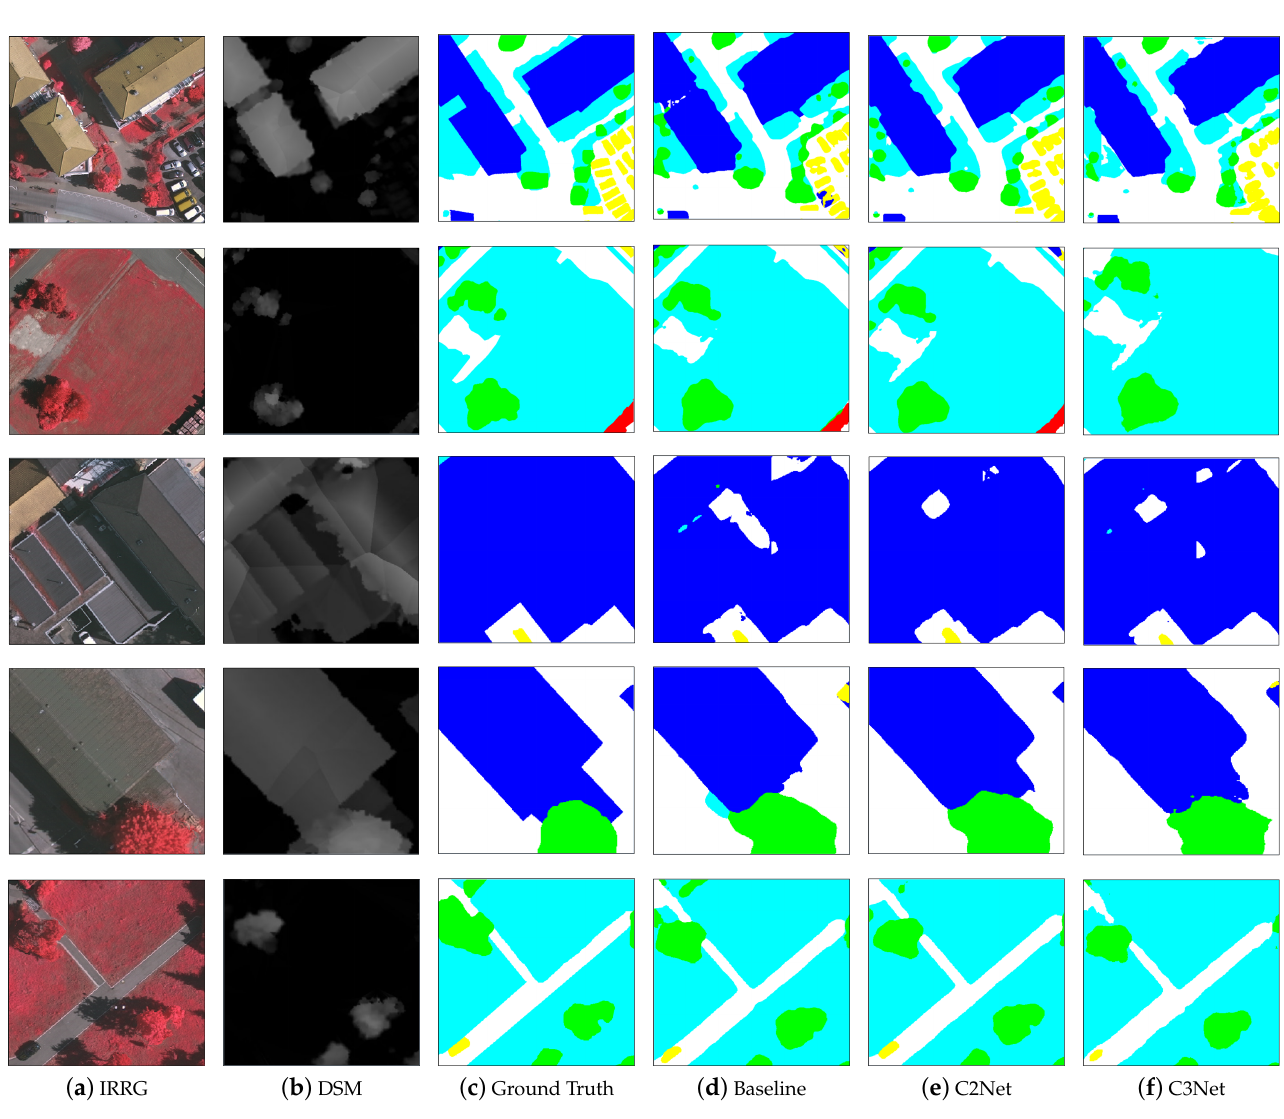
Figure 9. Semantic segmentation results on the ISPRS Vaihingen